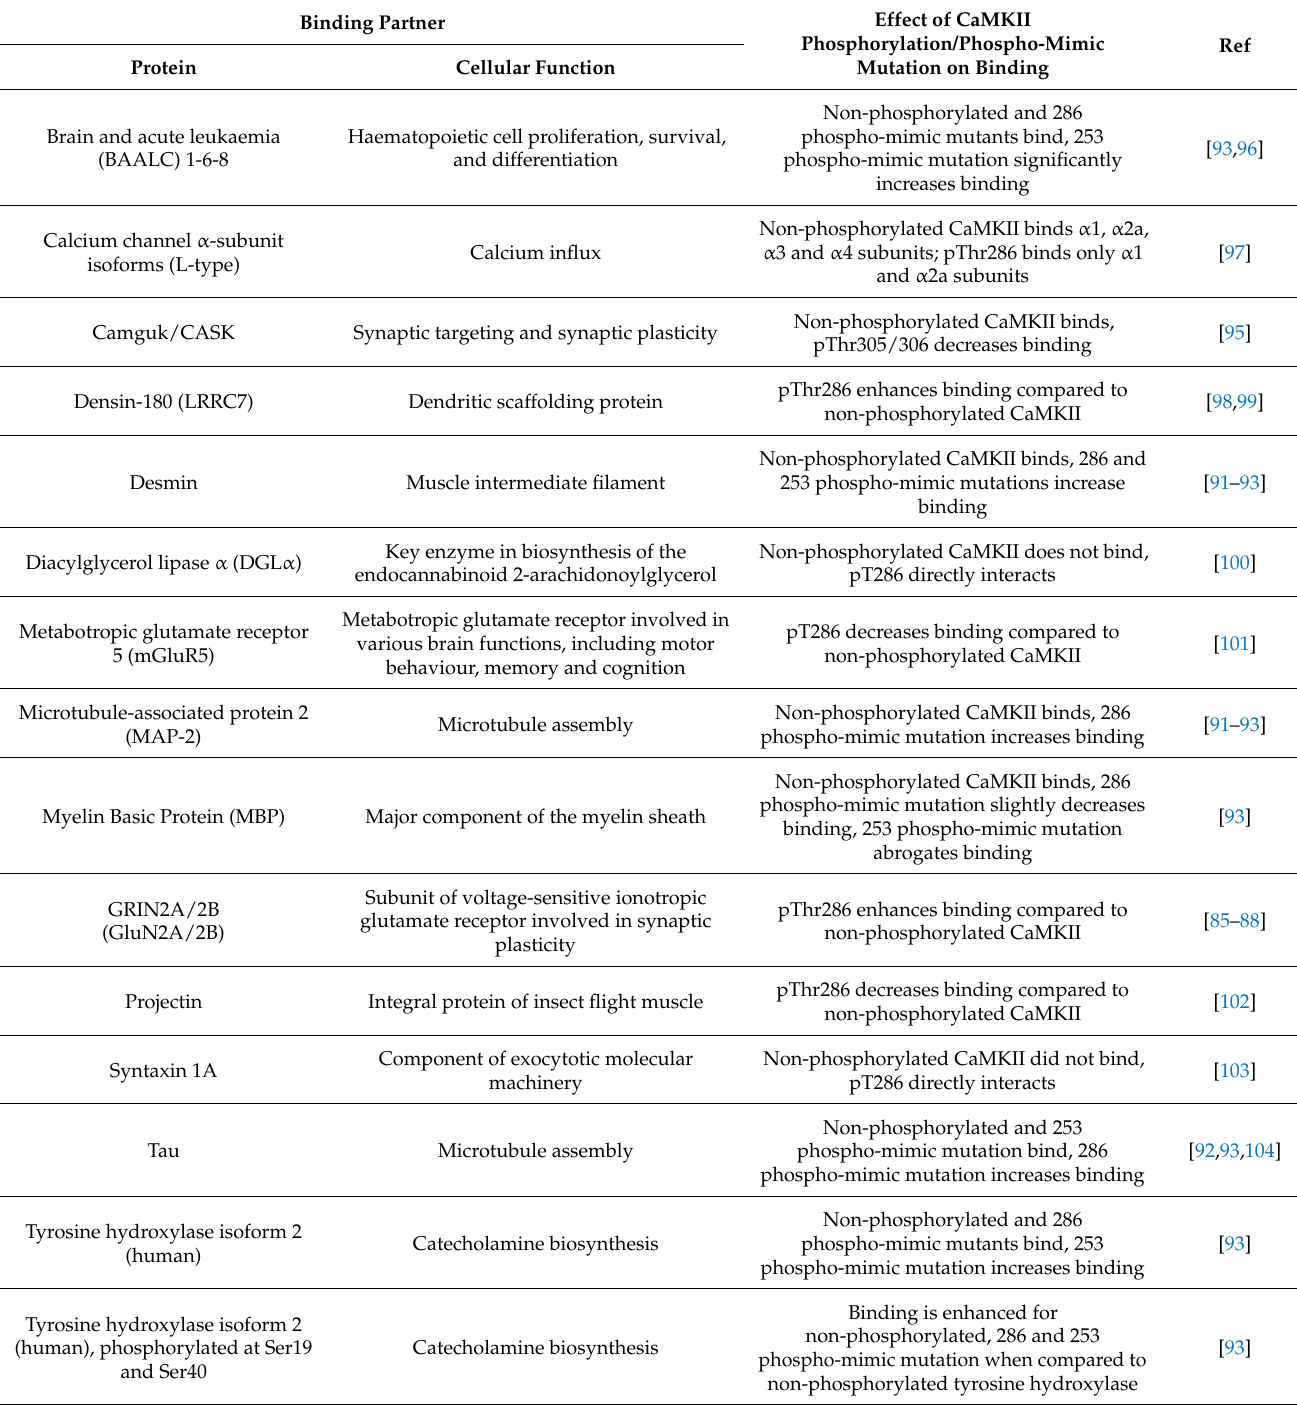
Table 2. Proteins that alter their binding to CaMKII in response to changes in CaMKII